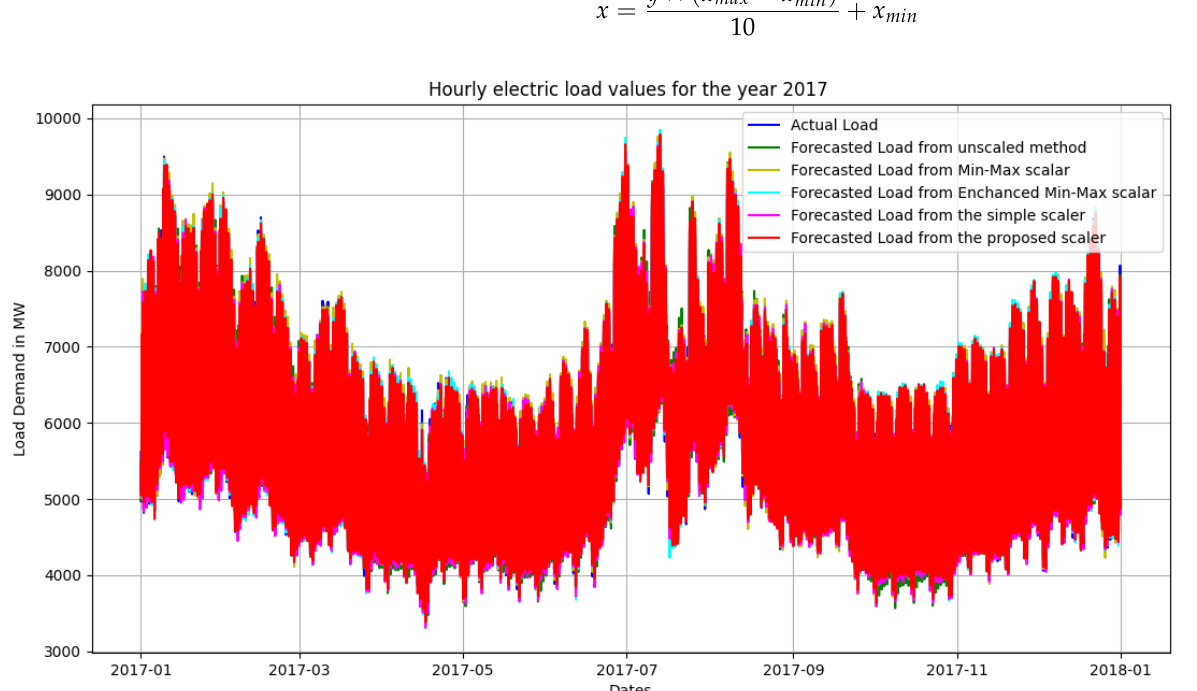
Figure 6. Graphic comparison of actual and predicted hourly load values for the year 2017. All pre-processing methods of the examined data are illustrated graphically.